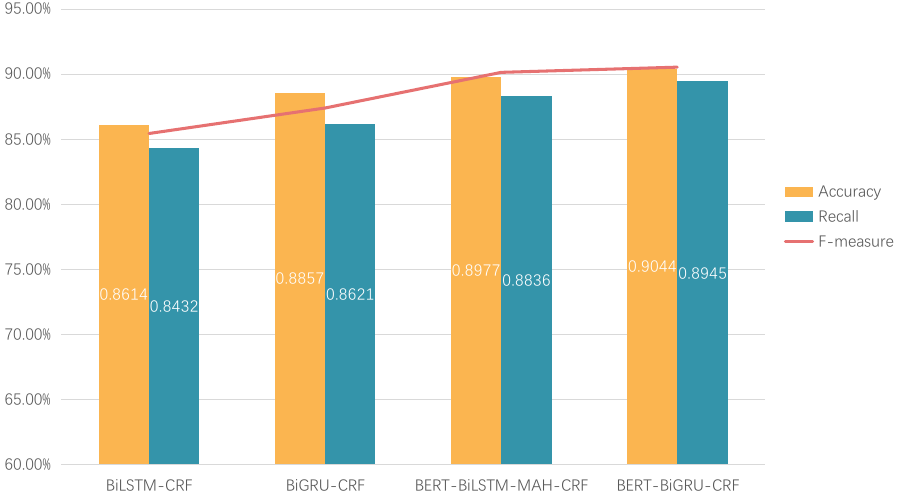
Figure 14. Ablation experiment, BERT layer.